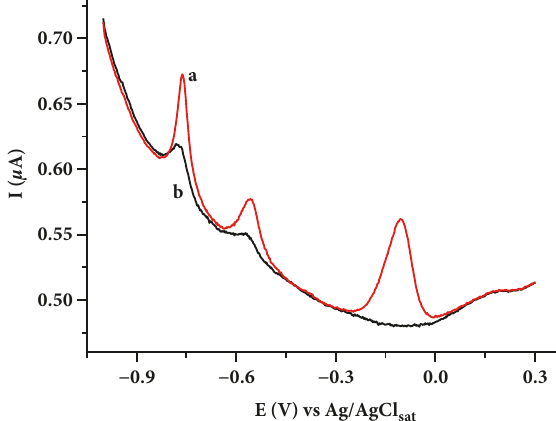
Figure 3: Differential pulse anodic stripping voltammograms obtained for Cd(II) and Pb(II) in 0.10 mol L −1 acetate buffer solution (pH 4.5) as supporting electrolyte; (a) 250 mg L −1 of Bi(III) dissolved in supporting electrolyte, (b) without Bi(III), determined with GE containing 142 𝜇 g L −1 of Cd(II) and Pb(II) ( E = -1.40 V; t = 250 s; potential step =1.95 mV; amplitude = 25 mV). dp dp